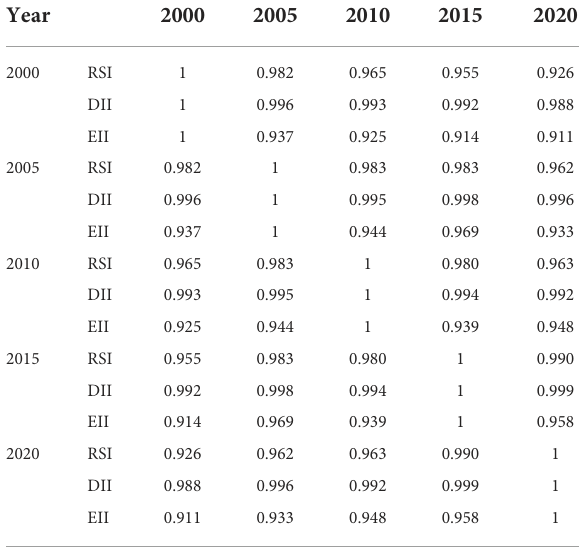
TABLE 5 Temporal correlation of the spatial interaction index